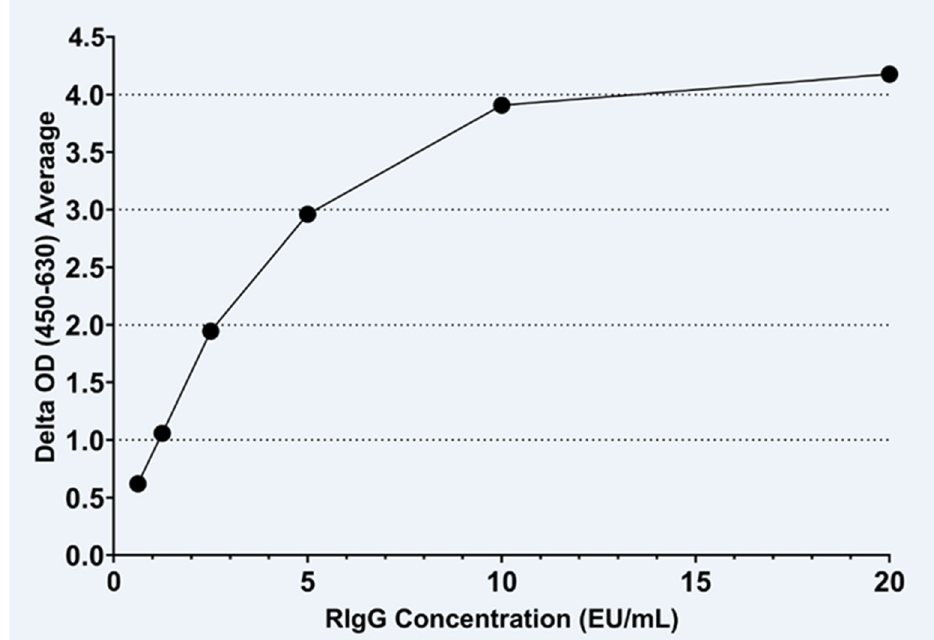
Figure 1. The IgG standard curve was constructed using the identified optimal dilution of the anti- human IgG-HRP conjugate to measure the OD value of serial two-fold dilutions of the RIgG internal standard (20 EU/mL per the Protein A ELISA); the EU/mL values were calculated by Gen5 software using non-linear curve fi t standard curve analysis.